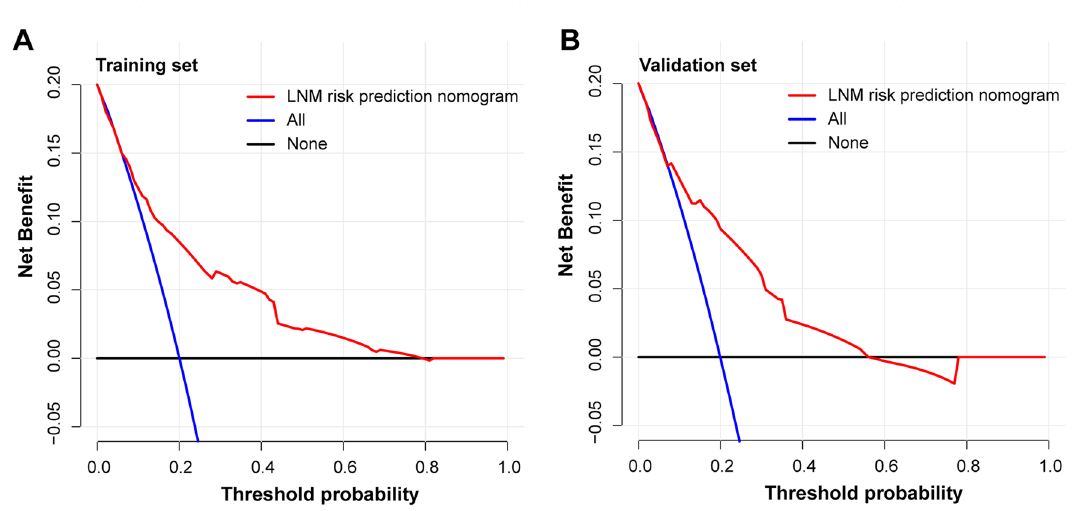
Figure 3. Calibration plot for the nomogram. Validity of the predictive performance of the nomogram in estimating the risk of LNM presence in the training cohort ( A ) and validation set ( B ).